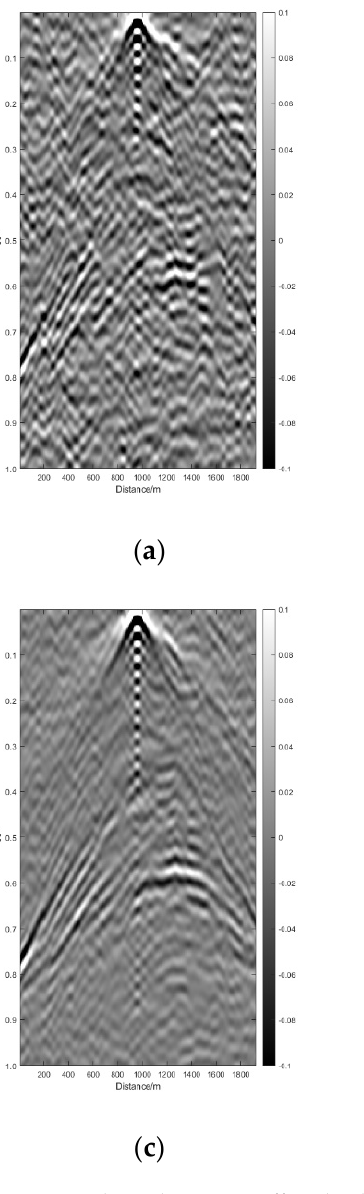
Figure 10. The 96th trace set effect display. ( a ) The reconstructed result of passive seismic records with short periods; ( b ) the result of the test data processed by the neural network; ( c ) the reconstructed result of passive seismic records with long periods. ( d ) Active-source forward modeling result.